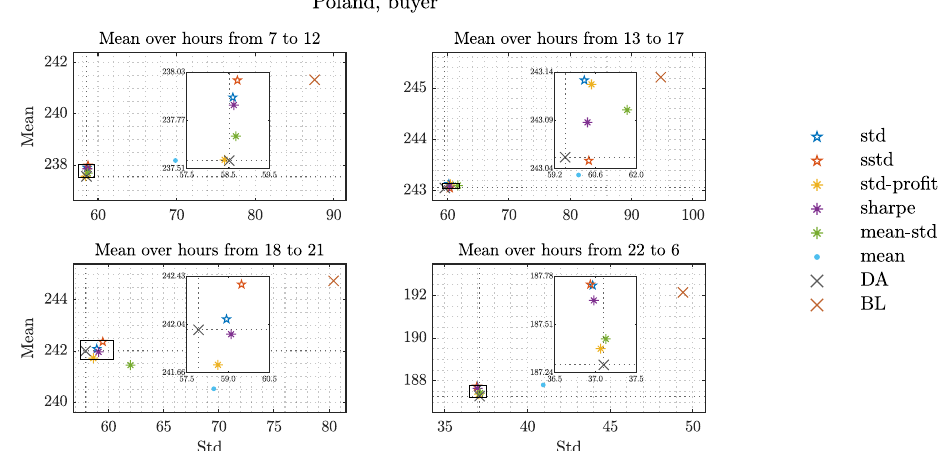
Figure 10. Average results of the portfolio allocation, ( σ h , t , E [ s h , t ]) obtained for a buyer in the Polish market using different strategies. The averages are calculated over all days in the validation window and hours within the considered blocks: 7–12, 13–17, 18–21, 22–6. The results of trading only on the day-ahead (DA) or balancing (BL) market are plotted as for reference. To improve visibility, a zoom from the area marked with rectangles is also plotted. Source: Authors’